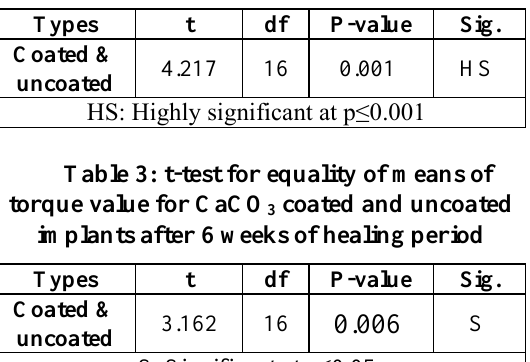
Table 2: t-test for equality of means of torque value for CaCO 3 coated and uncoated